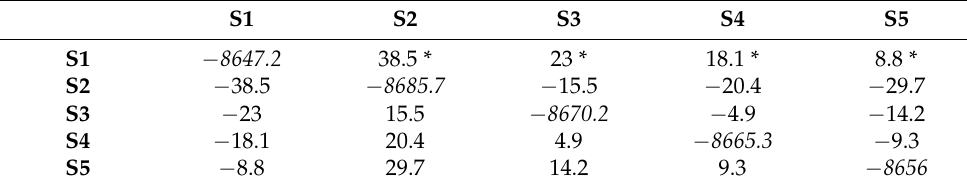
Table 1. Paired comparisons between different phylogenetic hypotheses using log (BF).